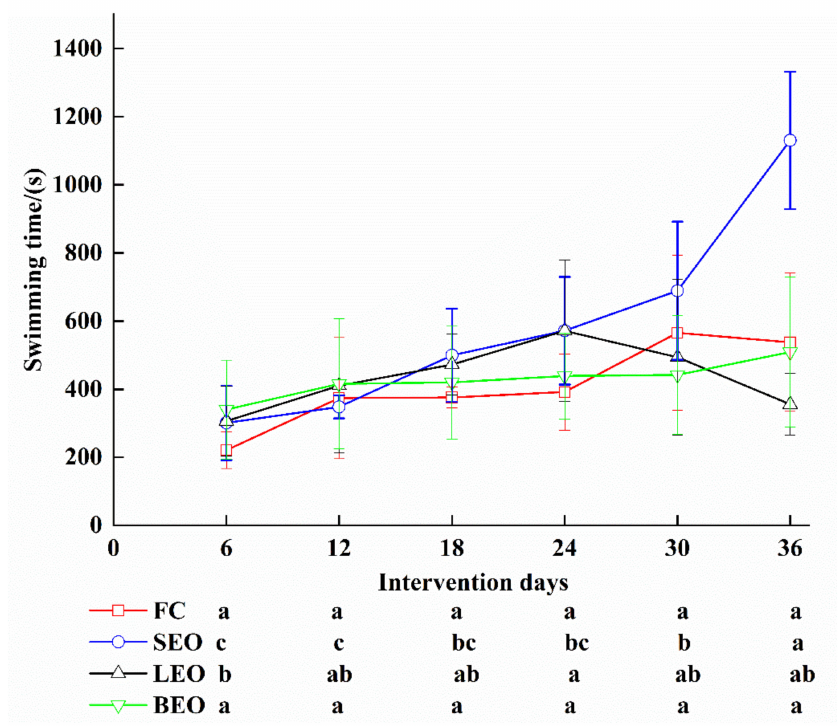
Figure 2. Effects of inhalation of the CEOs on swimming exhaustion time in rats. Data are the means ± SD. Different lowercase letters indicate significant differences, p <